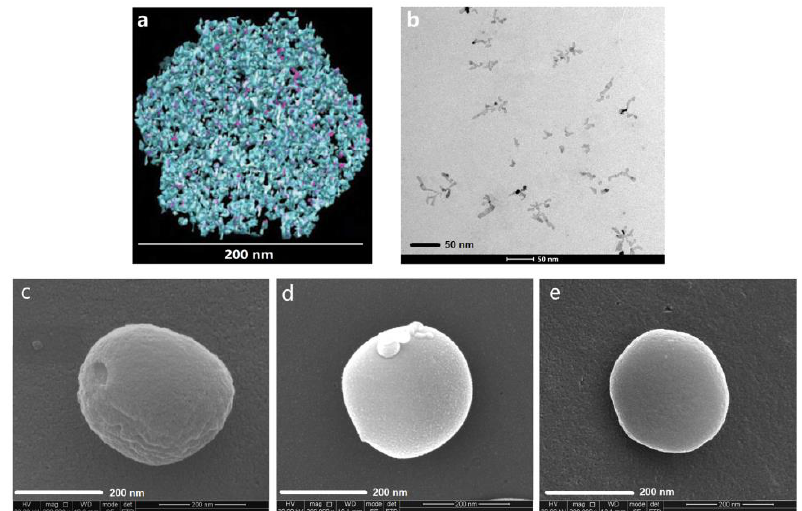
Figure 1. Modification of the casein-nanoparticles through phosphatidylcholine. ( a ) The image the casein-nanoparticle derived from cryo-transmission electron tomography comes from the literature [4], with permission from Elsevier, 2011; ( b ) TEM image of phosphatidylcholine (PC); ( c ) SEM image of casein-nanoparticles; ( d ) SEM image of PC-casein nanoparticles, ( e ) SEM image of CX-PC-casein-NPs.